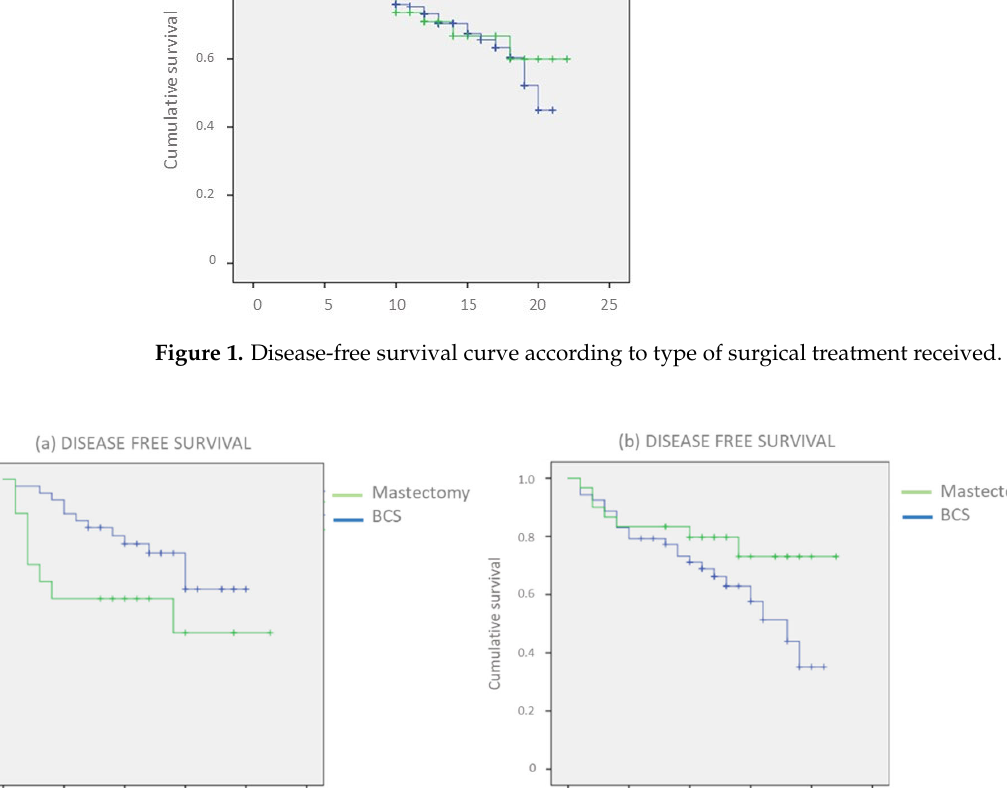
Figure 1. Disease ‐ free survival curve according to type of surgical treatment received.